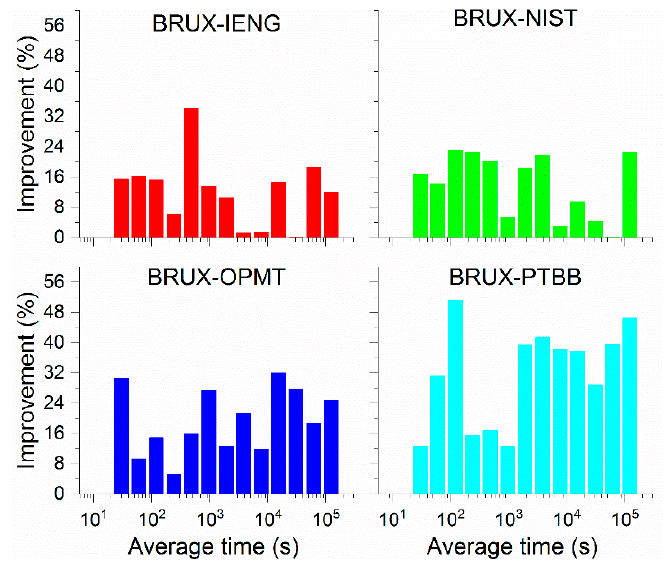
Figure 13. Percent of improvement of the frequency stability of scheme 2, compared to scheme 1.